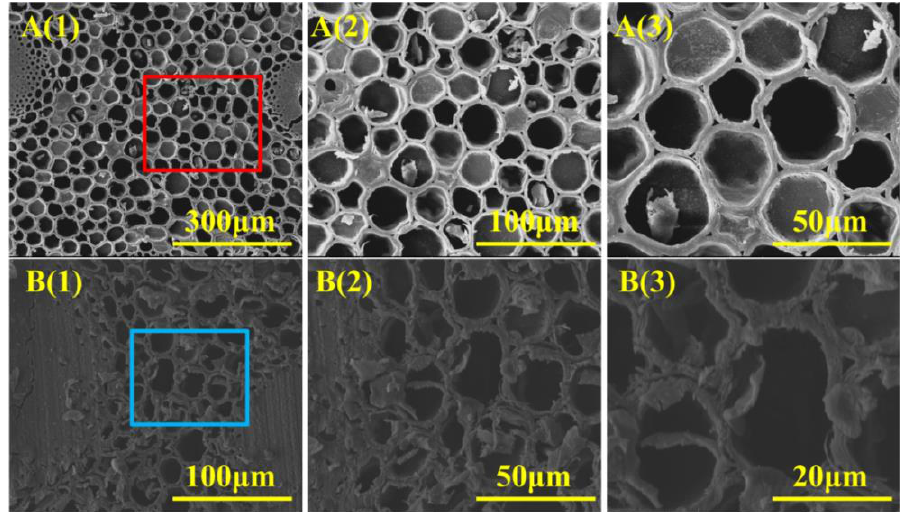
Figure 1. SEM images of the cross-section surface structure of Sample A ( A ( 1 ) – A ( 3 )) and Sample B ( B ( 1 ) – B ( 3 )). The different color boxes is the observation area.